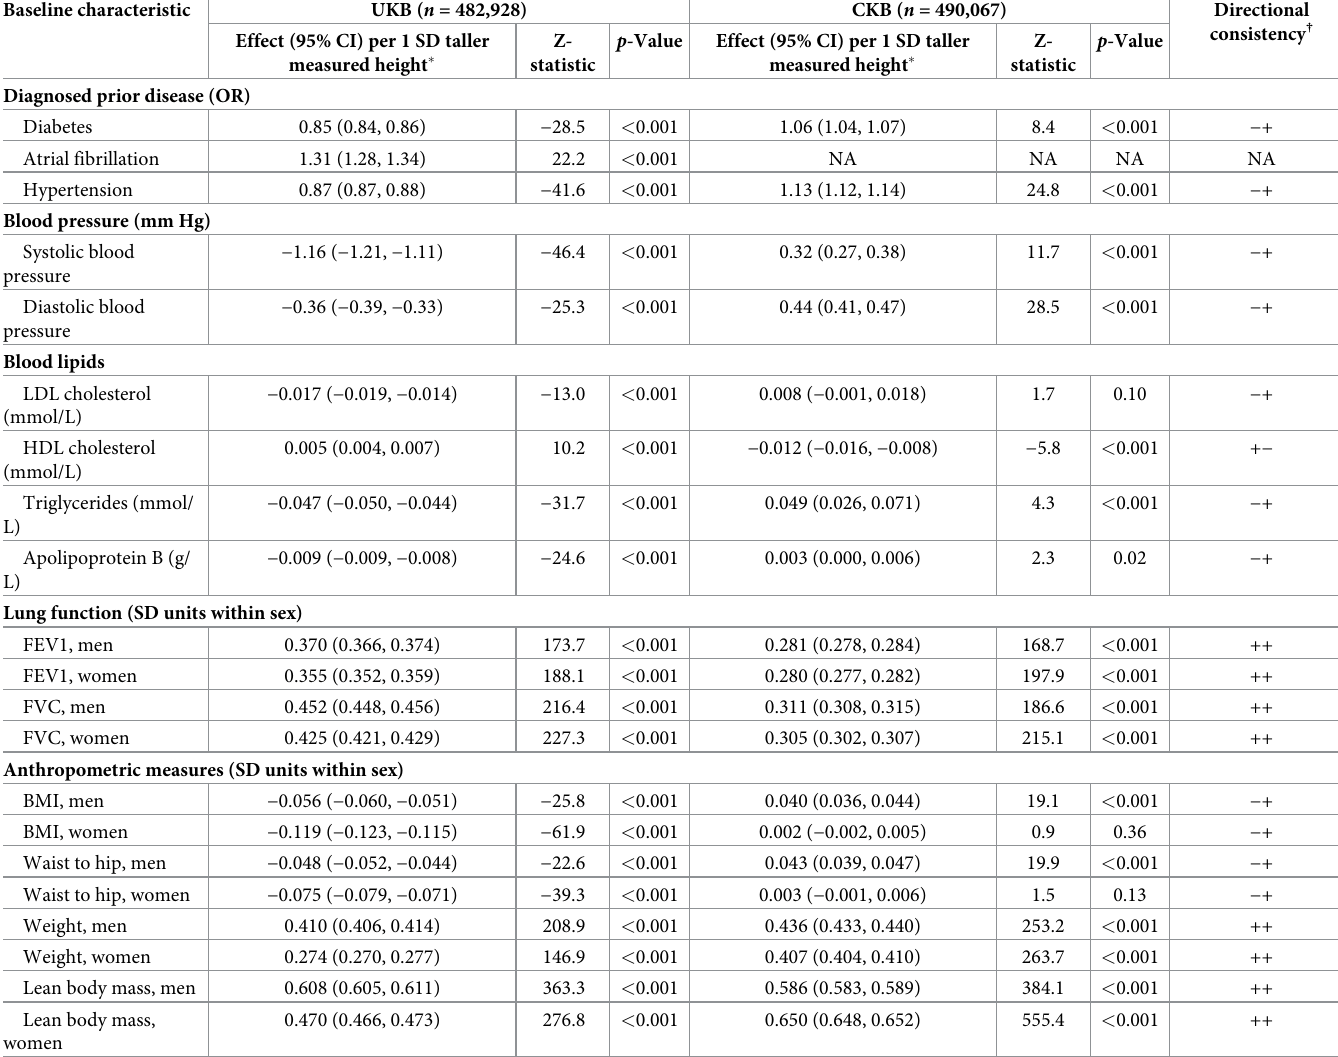
Table 2. Associations of measured height with cardiovascular risk factors and anthropometric traits in UKB and CKB. Baseline